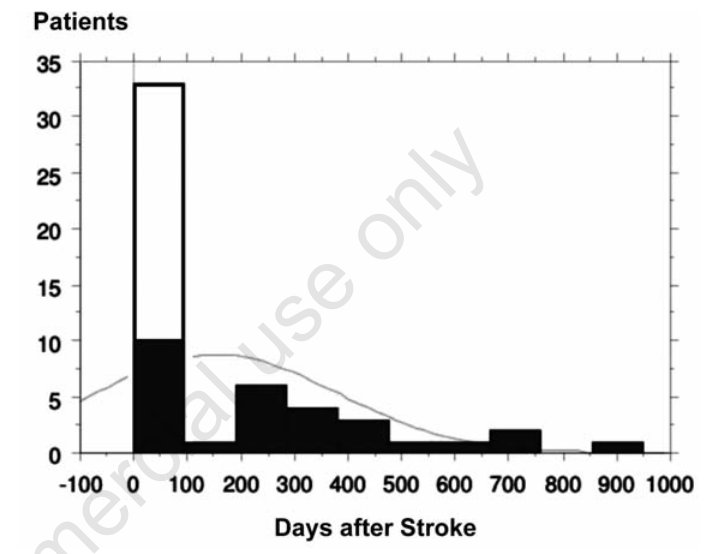
Figure 2. Distribution of dead patients following acute stroke. The majority of patients expired within the first 100 days. Note that 23 patients already died on the Stroke Unit (open column).